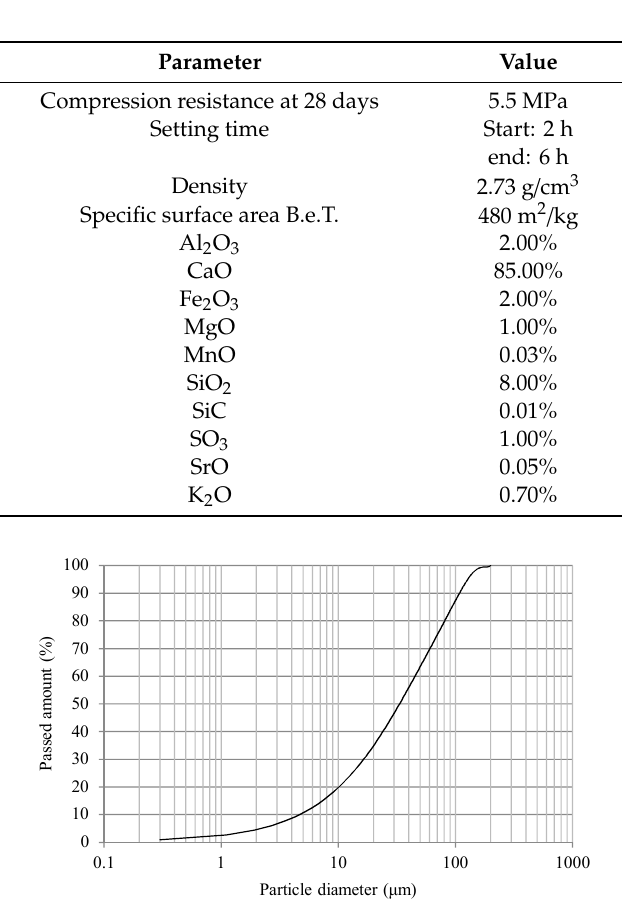
Figure 1. Particle size distribution of NHL. Figure 1. Particlе sizе distribution of NHL.